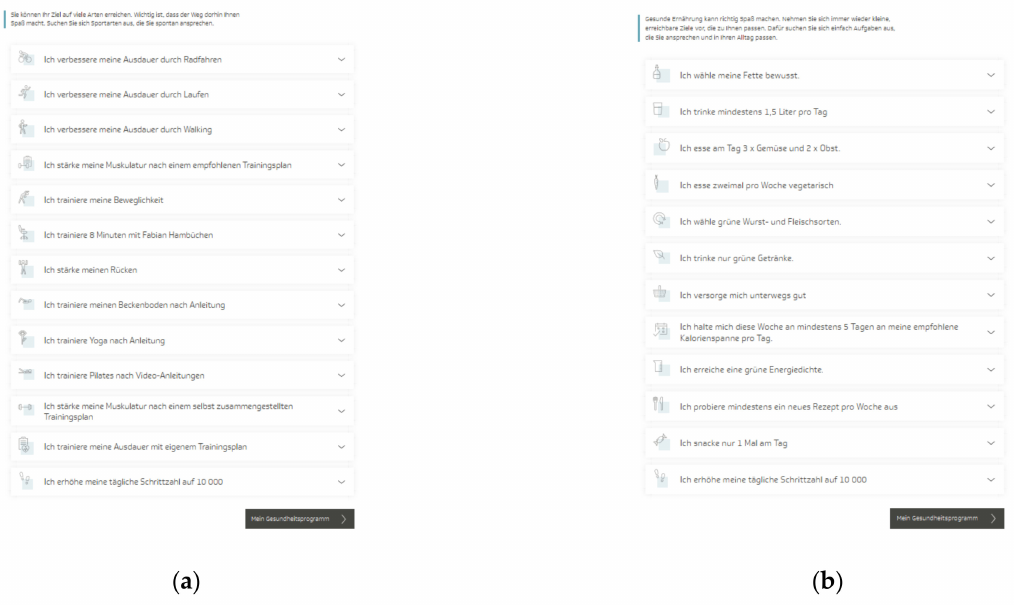
Figure 2. Activities of the “TK-HealthCoach” (TK-HC): ( a ) Fitness activities (“TK-FitnessCoaching” (TK-FC)); ( b ) weight loss activities (“TK-WeightLossCoaching” (TK-WC)). Source: Project’s landing page (https://gesundheitsprogramm.tk.de/de/studien/gesundheitsziele (accessed on 21 October